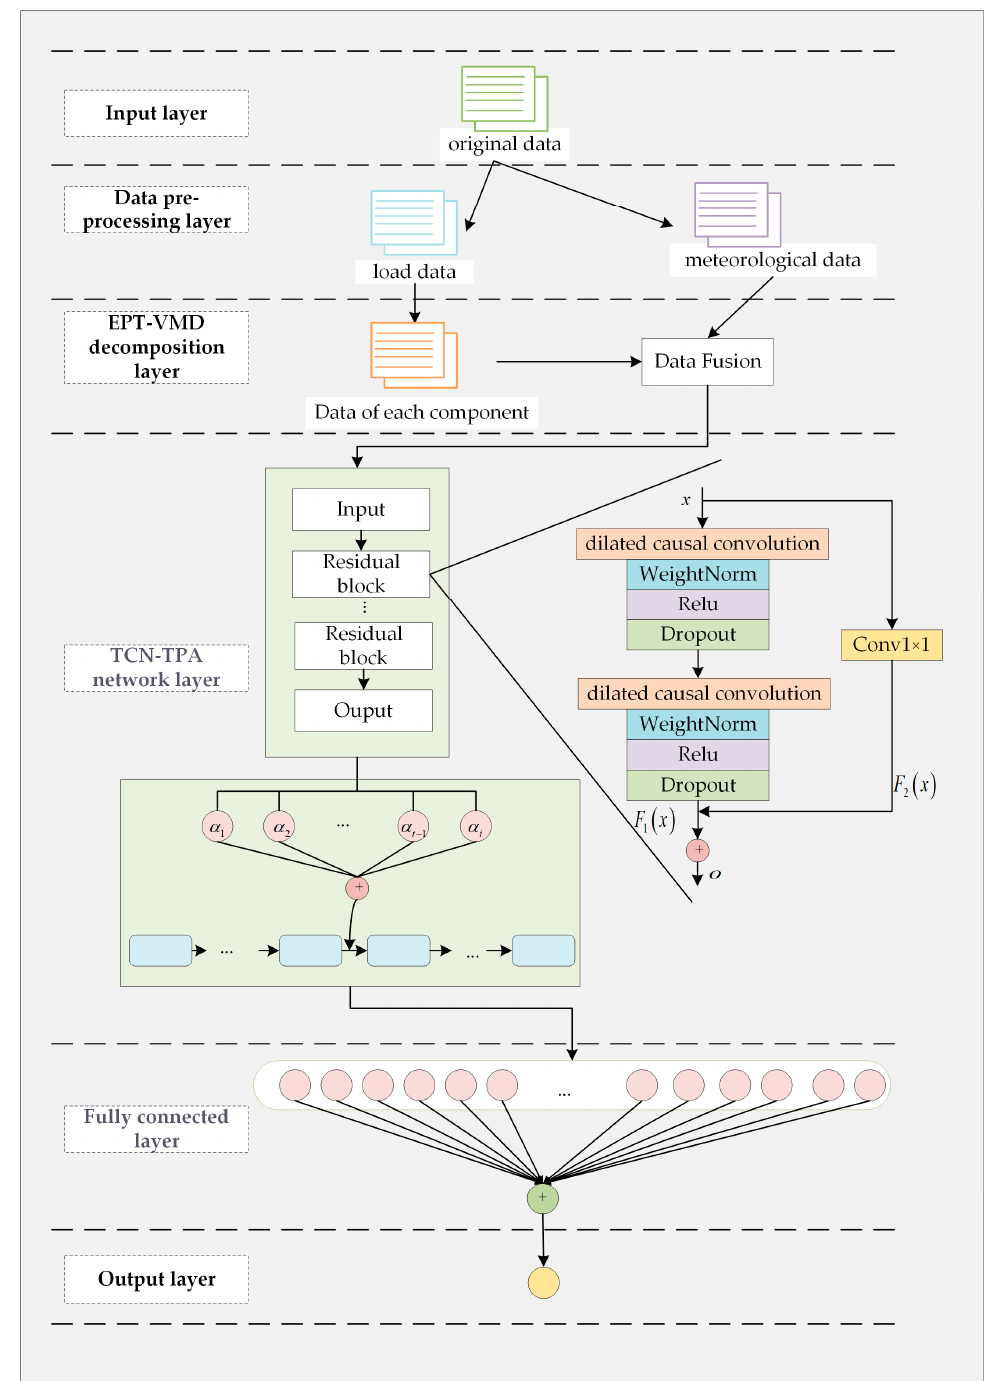
Figure 7. The structural framework of the EPT-VMD-TCN-TPA model.